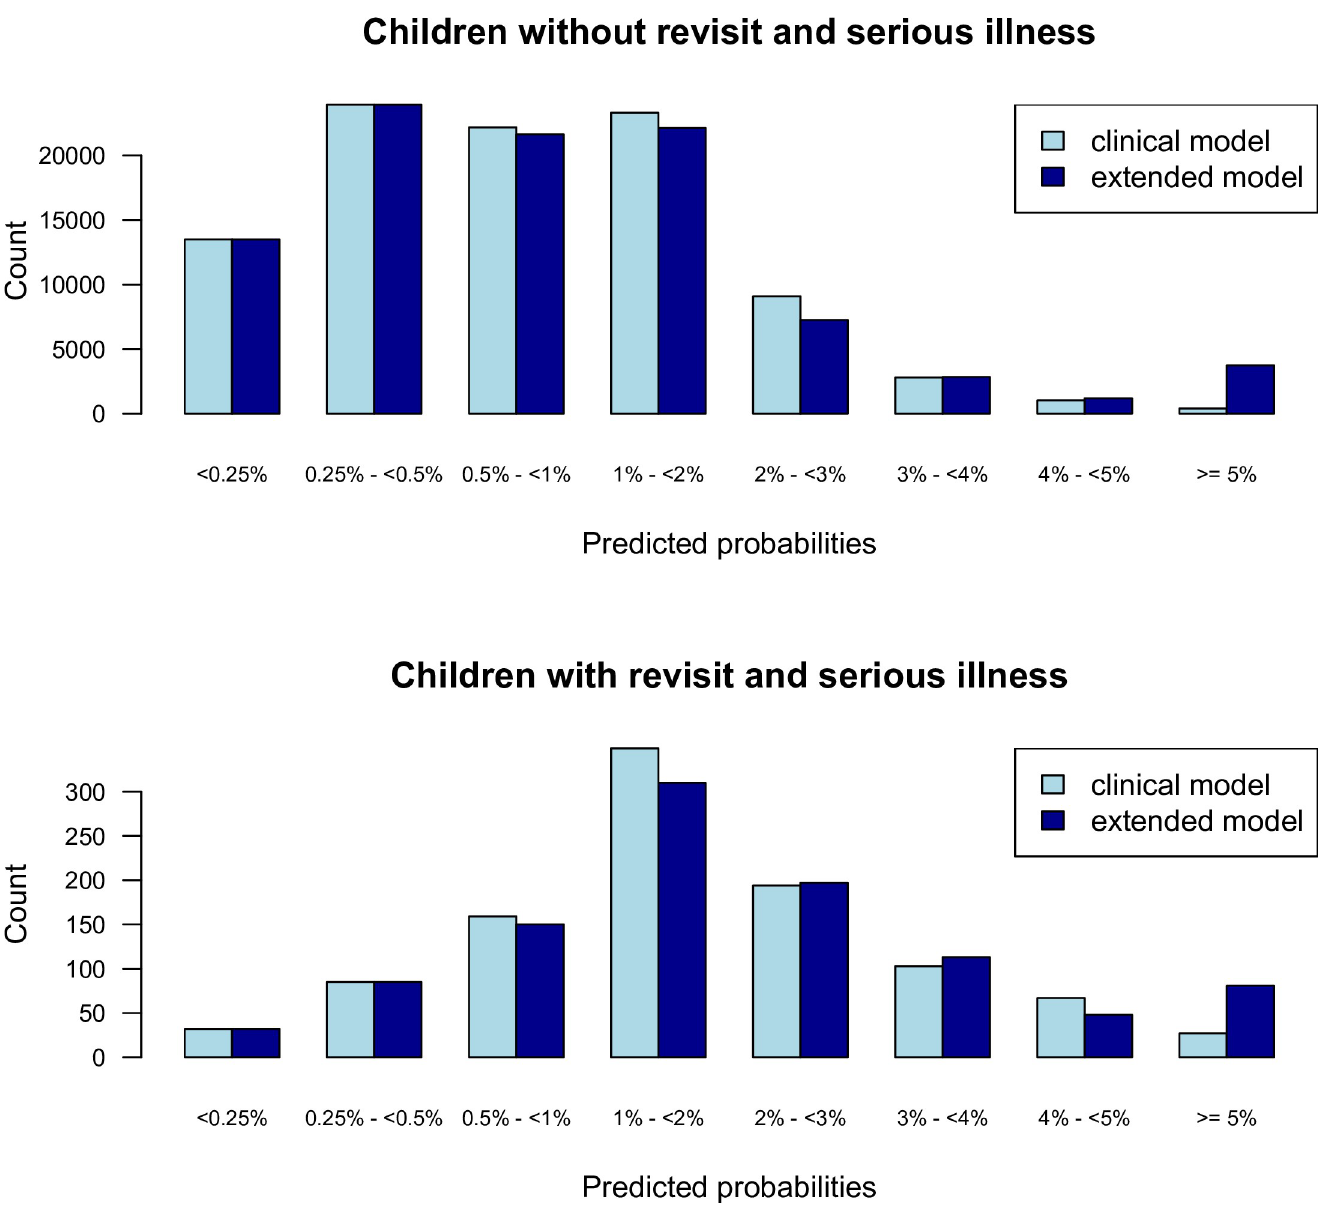
Fig 2. Barplots of the predicted probabilities of the two prediction models. Barplots showing the distributions of the predicted risks for the clinical model (top) and extended model (bottom).